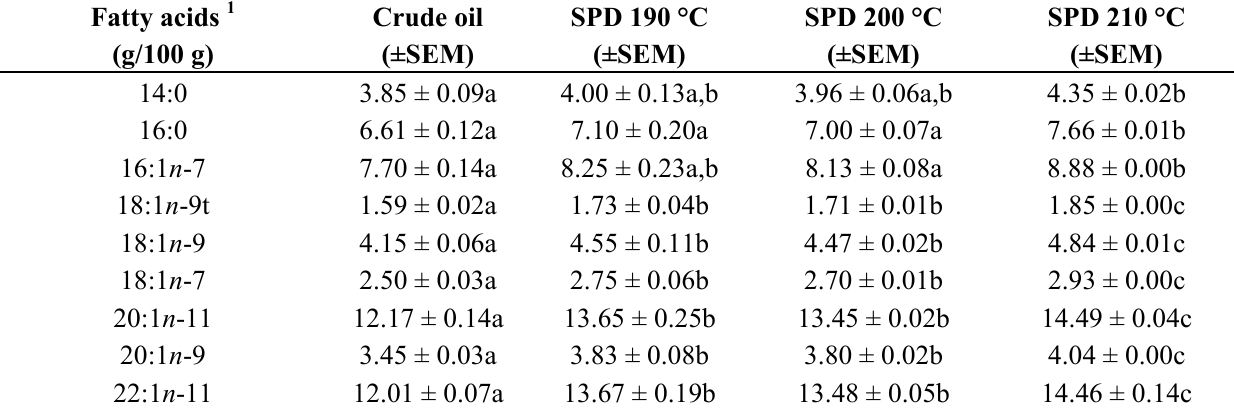
Table 1. Fatty acid (g/100 g oil) and unsaponifiable matter content of crude pollock oils (±SD) and pollock oils (±SD) purified by short-path distillation (SPD) with variable evaporator temperatures (190 °C, 200 °C, 210